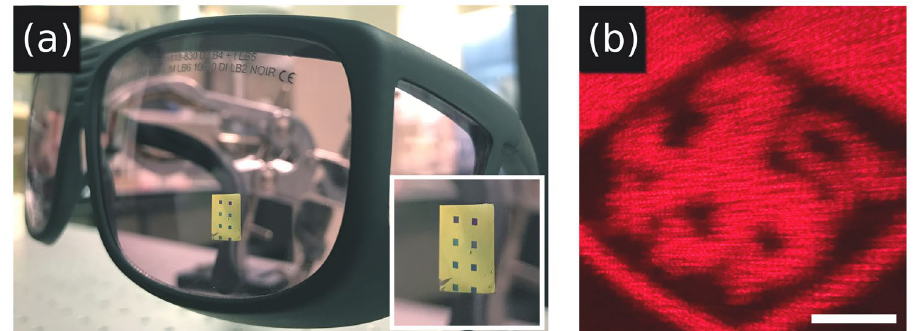
Figure 6. ( a ) Our MS conformed to a pair of safety glasses. The inset is a close up of the MS. ( b ) An experimentally obtained image with the MS conformed to the glasses for the incident light with a wavelength of 650 nm at normal incidence. The scale bar is 10 mm with a MS to screen spacing of 100 mm. The University of St Andrews logo is © University of St Andrews and used with permission. The Heriot-Watt logo is © Heriot-Watt University and used with